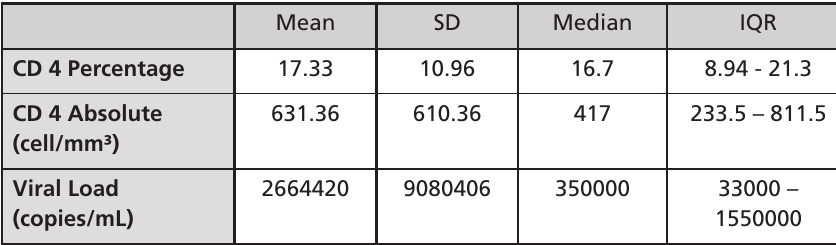
Figure 4: Breakdown of reasons for the status of ARV use Table 1: Immunological